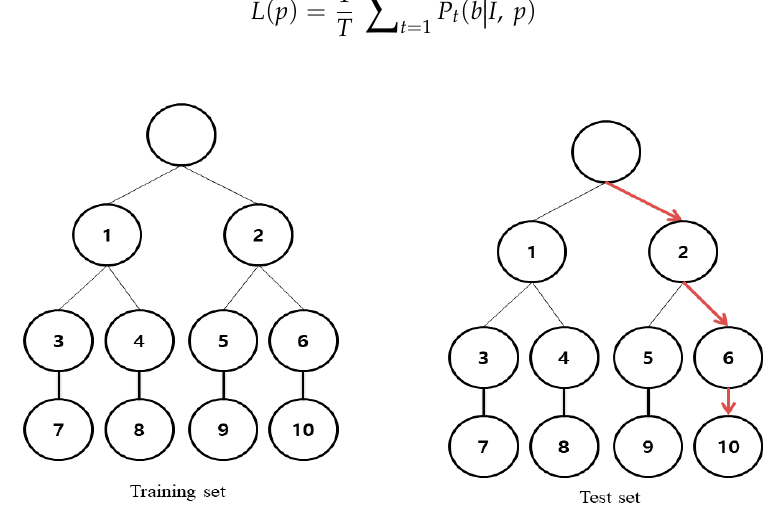
Figure 1. Examples of training and testing set.